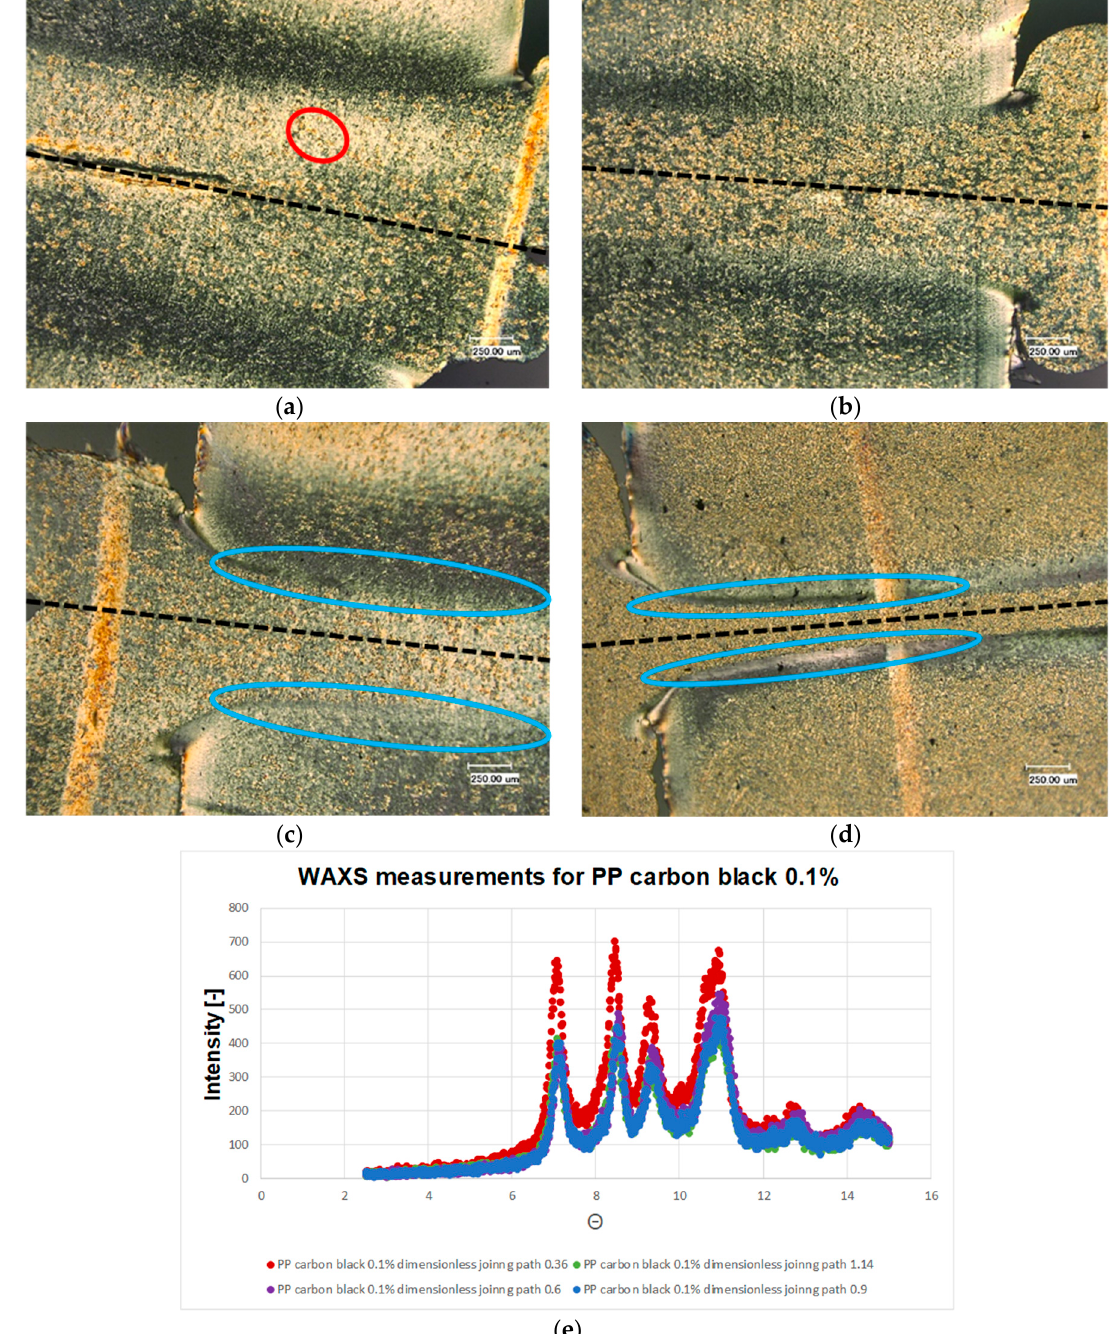
Figure 6. Microstructures of the welded PP carbon balck 0.1 with dimensionless joining path ( a ): 0.3; ( b ): 0.5; ( c ): 0.75; ( d ): 0.95; ( e ): WAXS measurement results of the welded PP carbon balck 0.1 for different joining paths. ● α -structure ● β -structure.